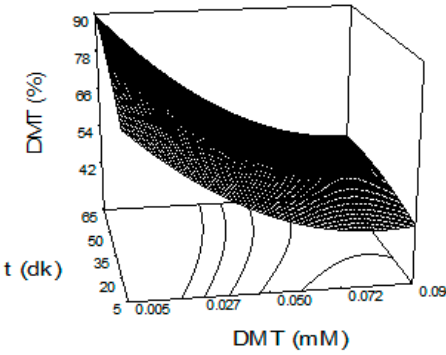
Figure 1. Effects of initial DMT concentration and initial reaction time on DMT oxidation.